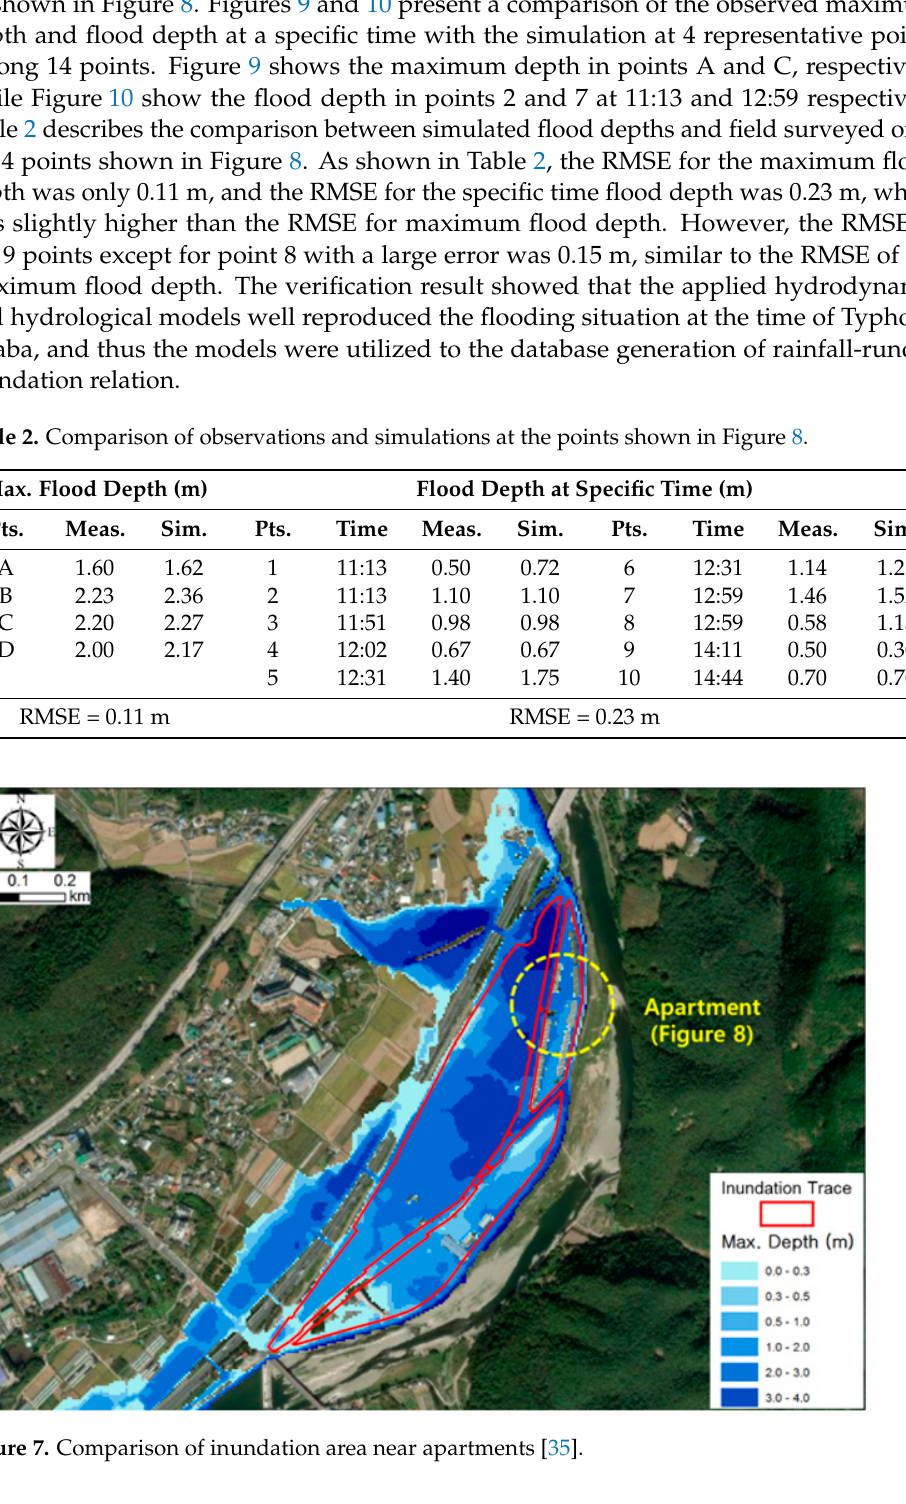
Figure 8. Verification points.